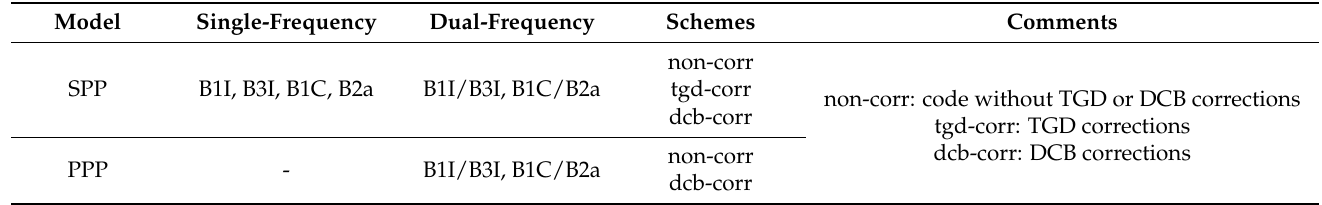
Table 2. Summary of the processing